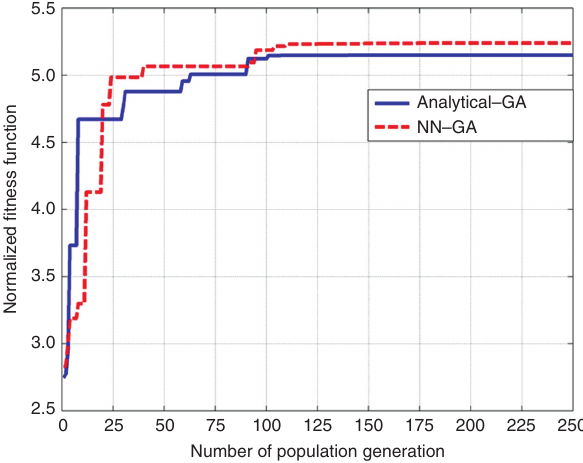
Figure 2 Comparison of objective function increase by GA and ANN and analytical solution for four-layer shell in w =